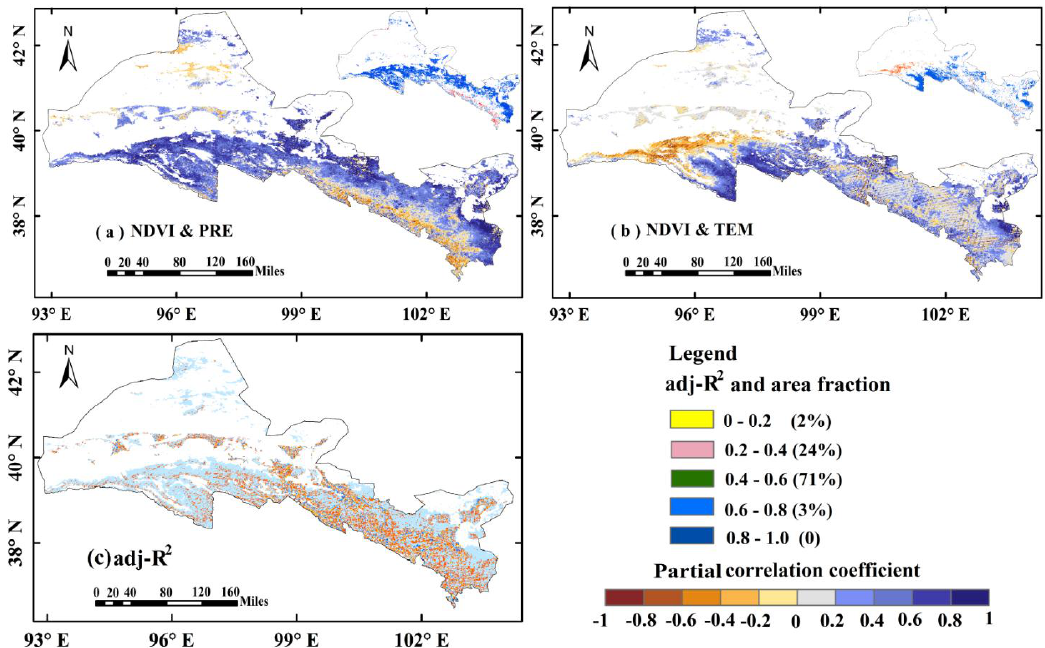
Figure 7. Spatial distribution of the partial correlation coefficients between NDVI and climate factors ( a and b ) and adj-R 2 ( c ) in 2000–2015. The inset maps show significantly ( p < 0.05) positive correlation between NDVI and climate (blue), and significantly ( p < 0.05) negative correlation between NDVI and climate (red).